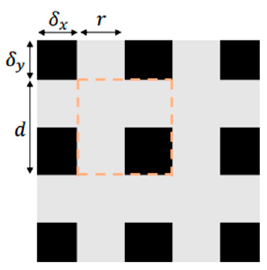
Figure 2. Images using different data augmentation techniques. Specifically, Gridmask generates a grid-like mask of the same size as the original image. Gridmask has only two values, 0 and 1, where 0 denotes the black-masked area and 1 denotes the transparent area. The greater the number of 1s in mask, the greater the proportion of original information that will be retained. The smaller the number of 1s in the mask, the lower the proportion of information in the original image but the higher the risk of underfitting the model. There are, in total, four parameters (i.e., r, d, δ x , δ y ) for the mesh (as shown in Figure 3) that affect the performance of extracted feature, where δ x and δ y , respectively, denote the width and height of a dropped square with value 0, r denotes the retained proportion of the input image, and d denotes the length of a square.